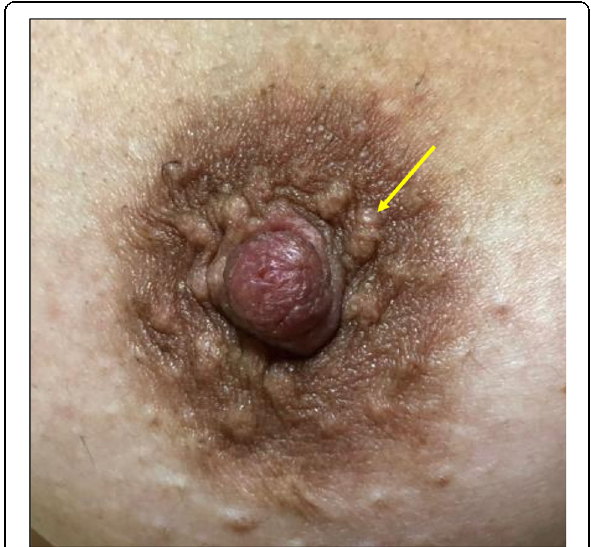
Anatomy and development Normal anatomy